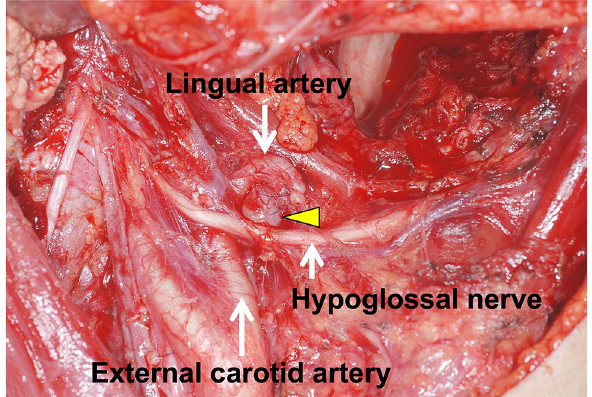
Figure 4. Imaging of subclinical lateral lingual lymph node metastasis in the parahyoid area. Supraomohyoid neck dissection and hemiglossectomy with a pull-through maneuver are performed. The lingual artery is ligated. Lateral lingual lymph node (arrowhead) is revealed below the lingual artery. This node is not shown in preoperative imaging.